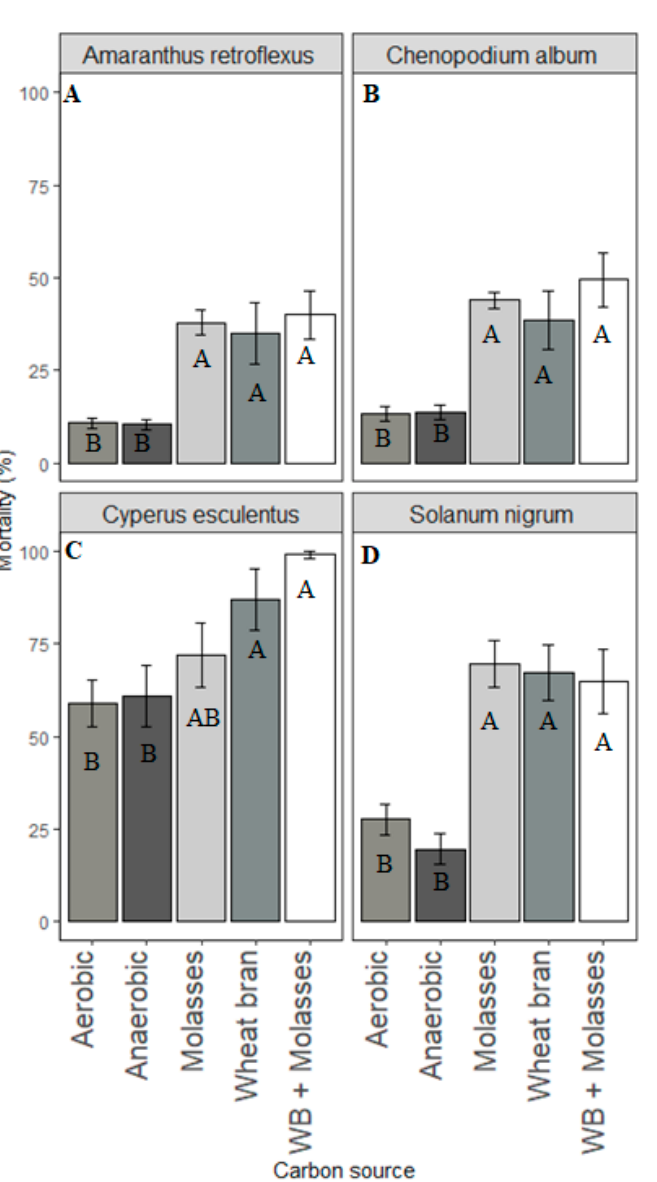
Figure 5. Effect of anaerobic soil disinfestation (ASD) carbon sources on propagule mortality of ( A ). redroot pigweed ( Amaranthus retroflexus ), ( B ). common lambsquarters ( Chenopodium album ), ( C ). yellow nutsedge ( Cyperus esculentus ) and, ( D ). black nightshade ( Solanum nigrum ) in field trials in Huron County 2017–2018. WB + Mol indicates 20.02 Mg ha − 1 wheat bran plus 10.01 Mg ha − 1 molasses. Means followed by different letters are significantly different at p -value < 0.05, according to Fisher’s LSD test after square root transformation. Data presented are from two independent experiments each with five replications. Error bars indicate standard